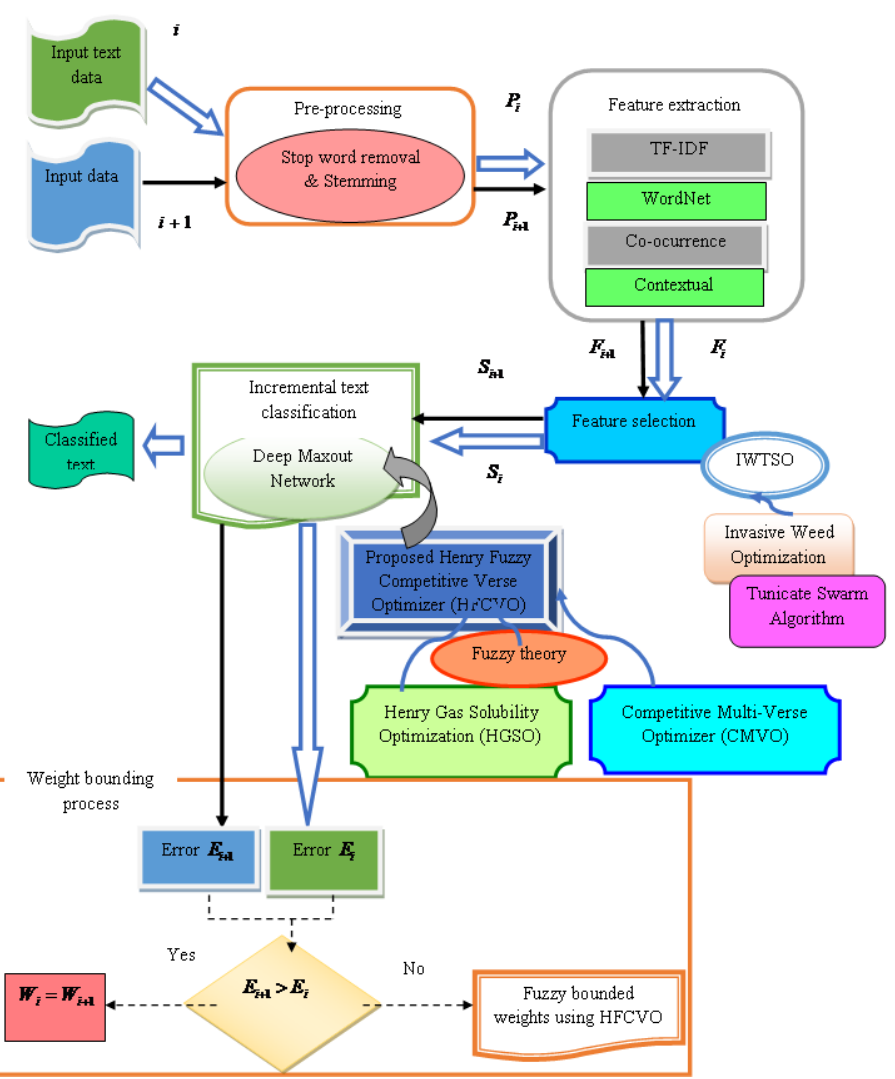
Figure 1. Schematic view of proposed HFCVO-based DMN for incremental text classification.